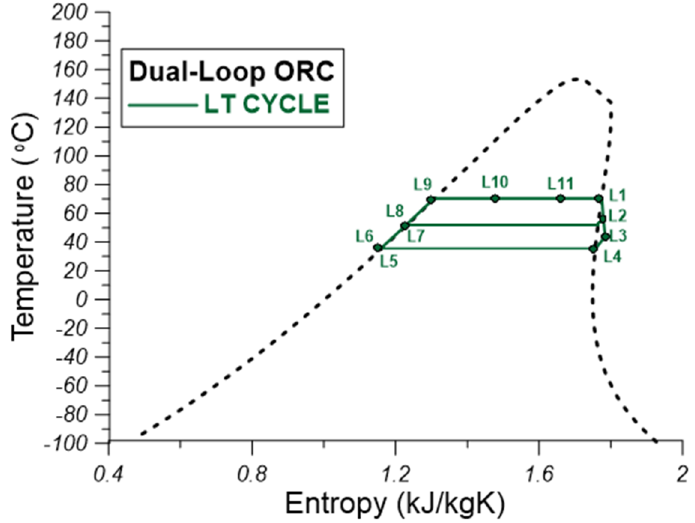
Figure 3. Representation of thermodynamic processes of the low temperature (LT) loop of the regenerative dual-loop ORC with OFOH in a T-s diagram.